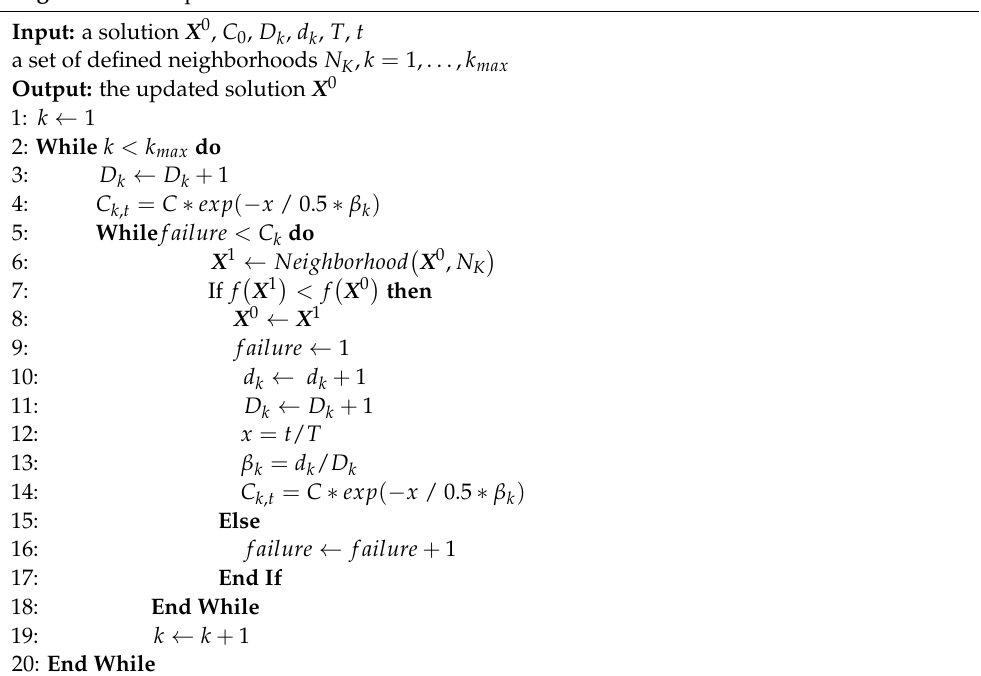
Algorithm 5 The procedure for local